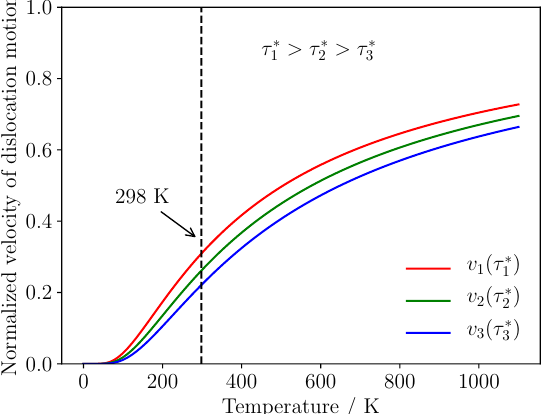
Figure 6. Normalized velocity of dislocation motion under different loading